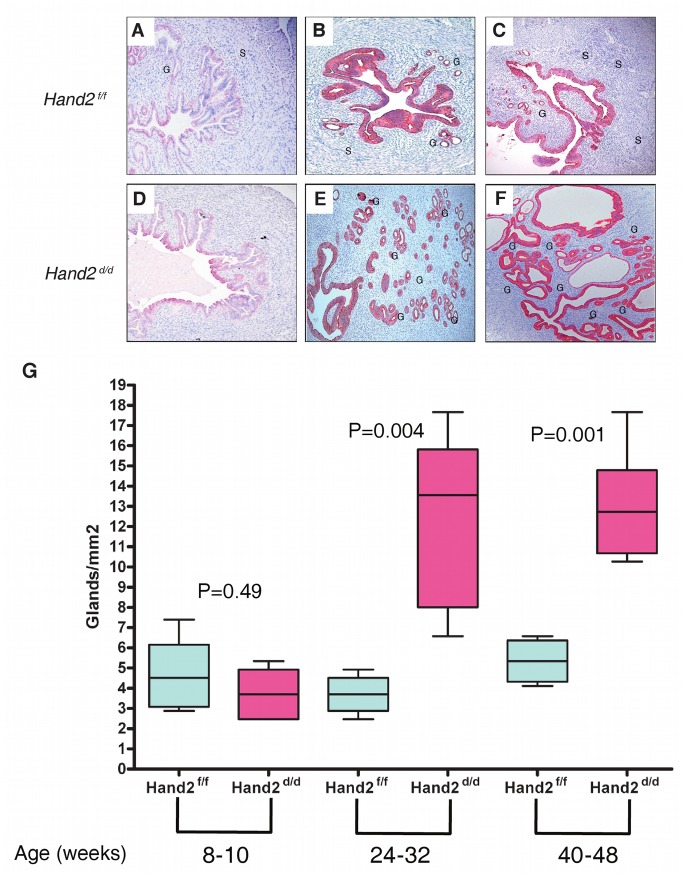
Endometrial hyperplasia in Hand2 conditional knock-out mice as a function of age.(A–F) Sections of uteri obtained from Hand2f/f (control) and Hand2d/d (null) mice were subjected to immunohistochemical staining with an antibody to cytokeratin 8, which marks the epithelial cells. Uterine sections were collected from mice of both genotypes at different ages. Representative uterine sections obtained from mice (n = 12) at 8–10 (A and D), 24–32 (B and E), and 40–48 (C and F) wk of age are shown. Note the increase in the gland/stroma ratio and the irregularity in the shape and size of the glands in Hand2d/d uteri compared to Hand2f/f uteri. G, gland; S, stroma. Magnification 20×. (G) Boxplots comparing the number of glands in uterine sections of Hand2f/f (control) and Hand2d/d (null) mice as a function of age. The number of endometrial glands was determined by counting the glands from three different regions of the uterine horn and is expressed as mean ± standard error. Statistical analysis was performed using a t-test. Boxes are median (interquartile range), and whiskers indicate range.